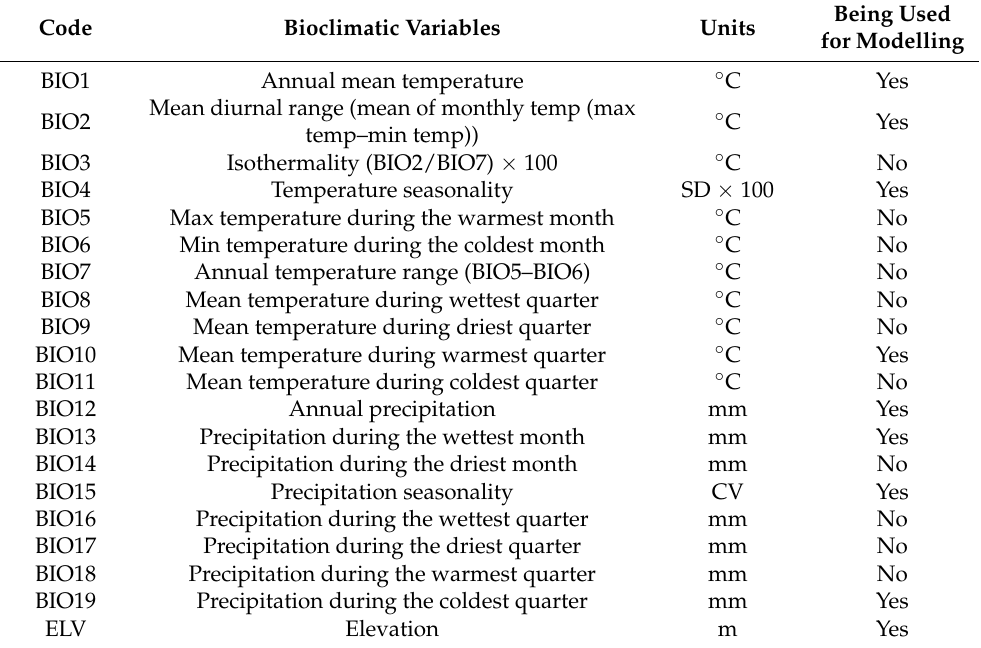
Table 1. Bioclimatic variables are often used in species distribution modelling and related ecological modelling techniques. The variables are derived from minimum, maximum, and mean temperature and mean precipitation values and are related to the distribution of Microplitis manilae . Being Used Code Bioclimatic Variables Units for Modelling BIO1 Annual mean temperature ◦ C Yes Mean diurnal range (mean of monthly temp (max ◦ C Yes BIO2 temp–min temp)) BIO3 Isothermality (BIO2/BIO7) × 100 ◦ C No BIO4 Temperature seasonality SD ×